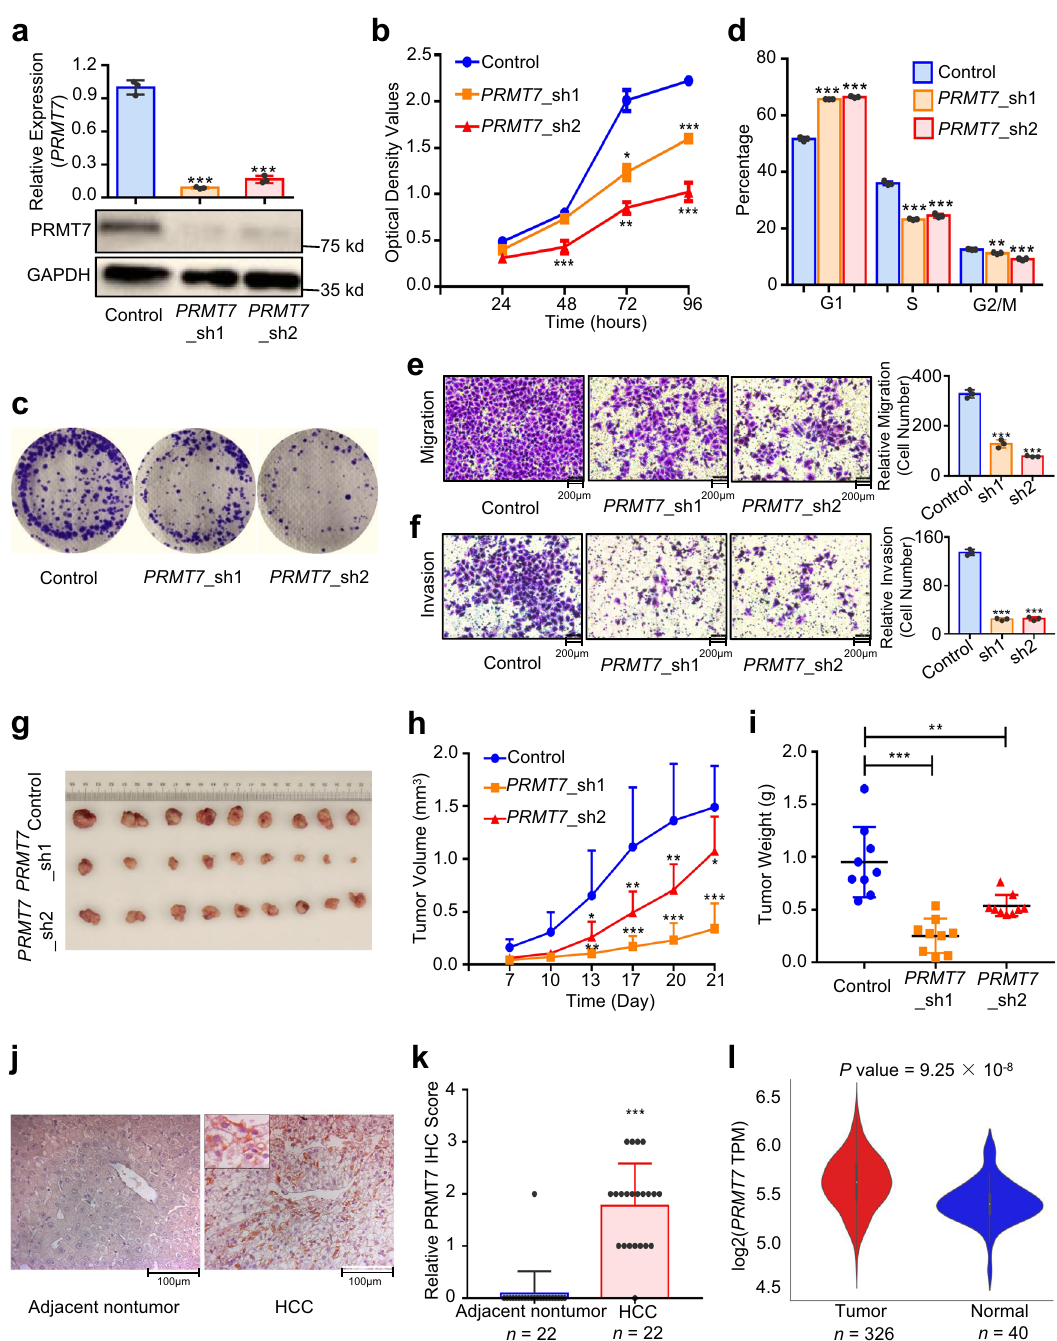
Fig. 6e – h, the CAGCTG-containing region in the promoter of the four genes had signi fi cant enrichment of H4R3me2s compared to